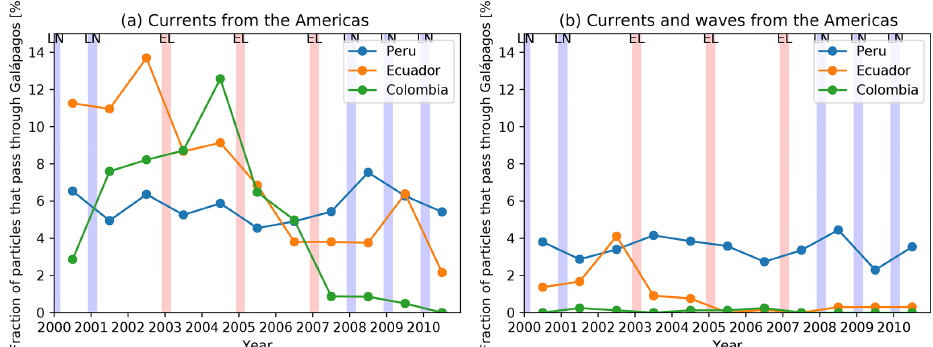
Figure 7. Time series of the fraction of particles starting in Peru, Ecuador, and Colombia that pass through the Galápagos region and for particles carried by currents only (a) and for particles carried by the currents and waves (b) . Blue bars indicate La Niña periods and red bars indicate El Niño periods. While there is no apparent relation between ENSO (El Niño Southern Oscillation) state for Peru and Ecuador, it is clear that the fraction of particles carried by currents only that end up in the Galápagos region from Colombia is much higher during El Niño than during La Niña